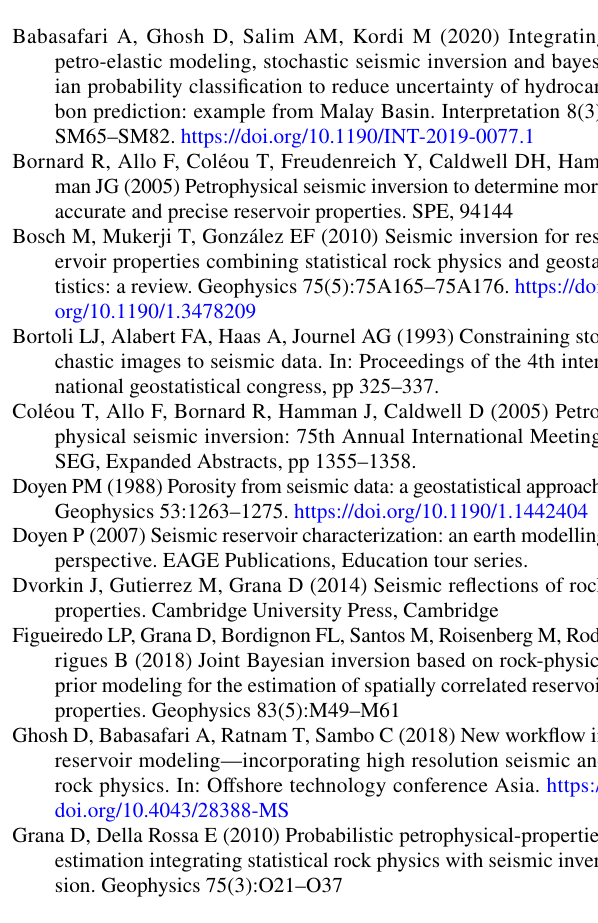
Fig. 9. 2D cross section of predicted clay volume using petrophysical seismic inversion